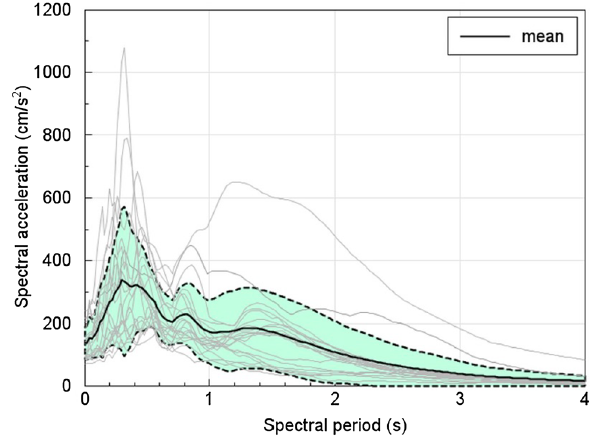
Fig. 5 Absolute acceleration response spectra for the 20 representa- tive horizontal components used for the nonlinear time-history analyses ( NTHA ), as well as the mean value and mean ± one standard deviation values (green contour)